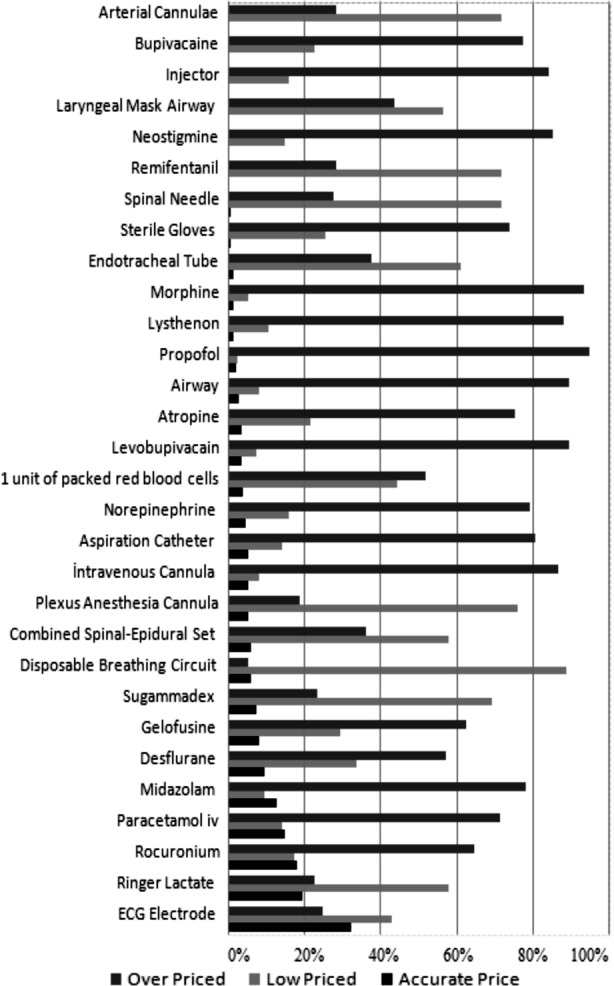
Distribution of answers to survey questions.